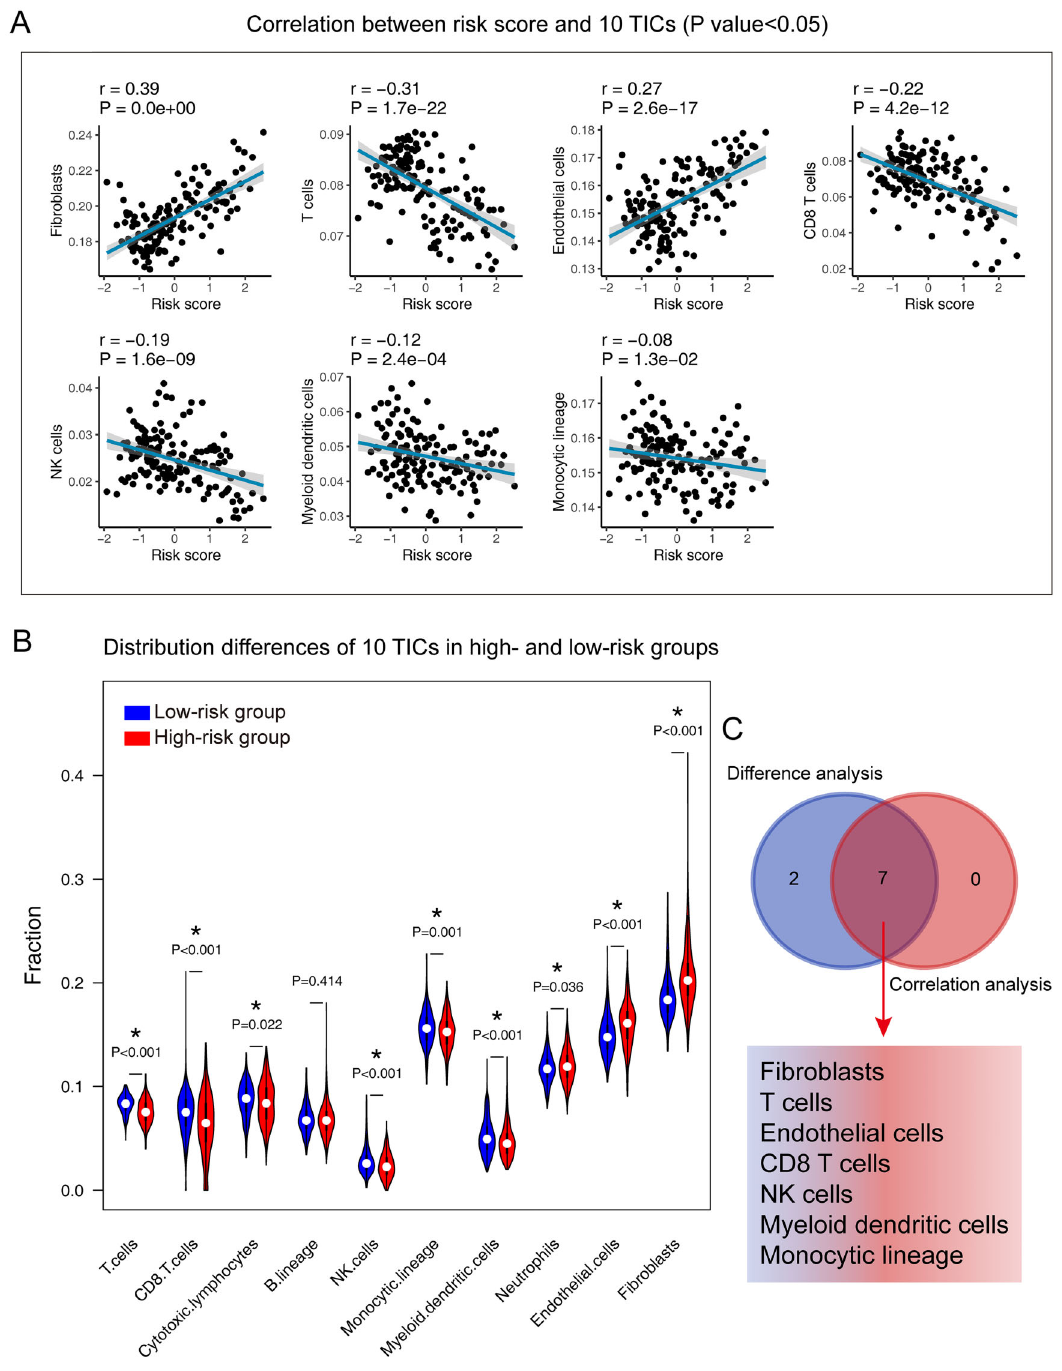
Figure 9. Correlation of TICs proportion with the eight-gene signature risk score in the Pediatric Brain Tumor Atlas (CBTTC) cohort (MCP-counter method). A , The blue line in each plot is the fi tted linear model indicating the proportion tropism of the immune cell with risk score. The shade around the blue line represents the 95% con fi dence interval. Spearman coef fi cient was used for the correlation test. B , Violin plot showing the ratio differentiation of 10 types of immune cells between PBTsamples from low- and high-risk groups to the median risk score. Wilcoxon rank sum test was used to assess for signi fi cance. C , Venn plot displays 7 TICs correlated with risk score co-determined by difference and correlation tests shown in violin and scatter plots, respectively. P value o 0.05 was the cutoff. TIC: tumor-in fi ltrating immune cell; PBT: pediatric brain tumor. Braz J Med Biol Res | doi: